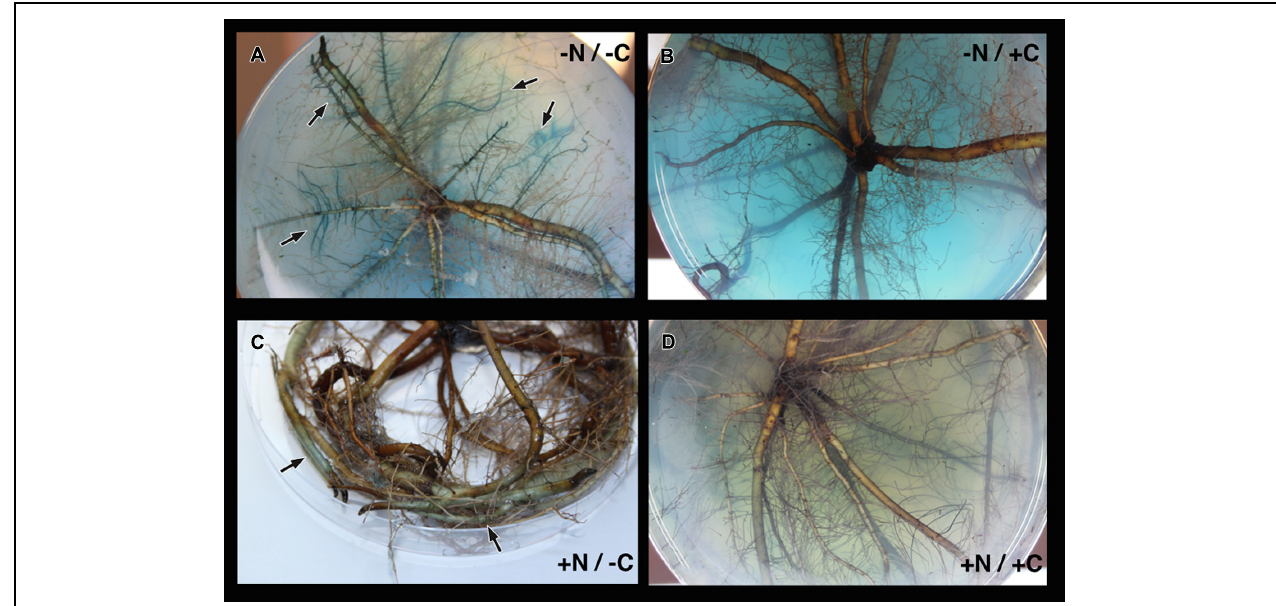
FIGURE 4 | Colonization of M. mangrovicola Gal22 transformants carrying gusA on R. mangle roots. (A) Strong colonization and nitrogenase activity was visualized by the blue color formation from gusA activity in − N/ − C